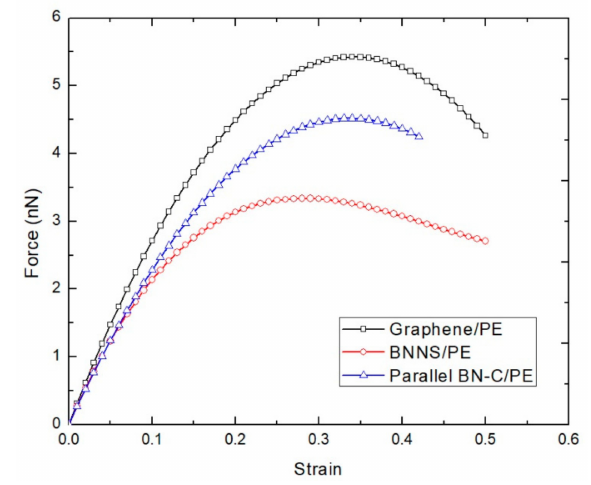
Figure 7. Force–strain plot of BN–C / PE nanocomposite variants at 300